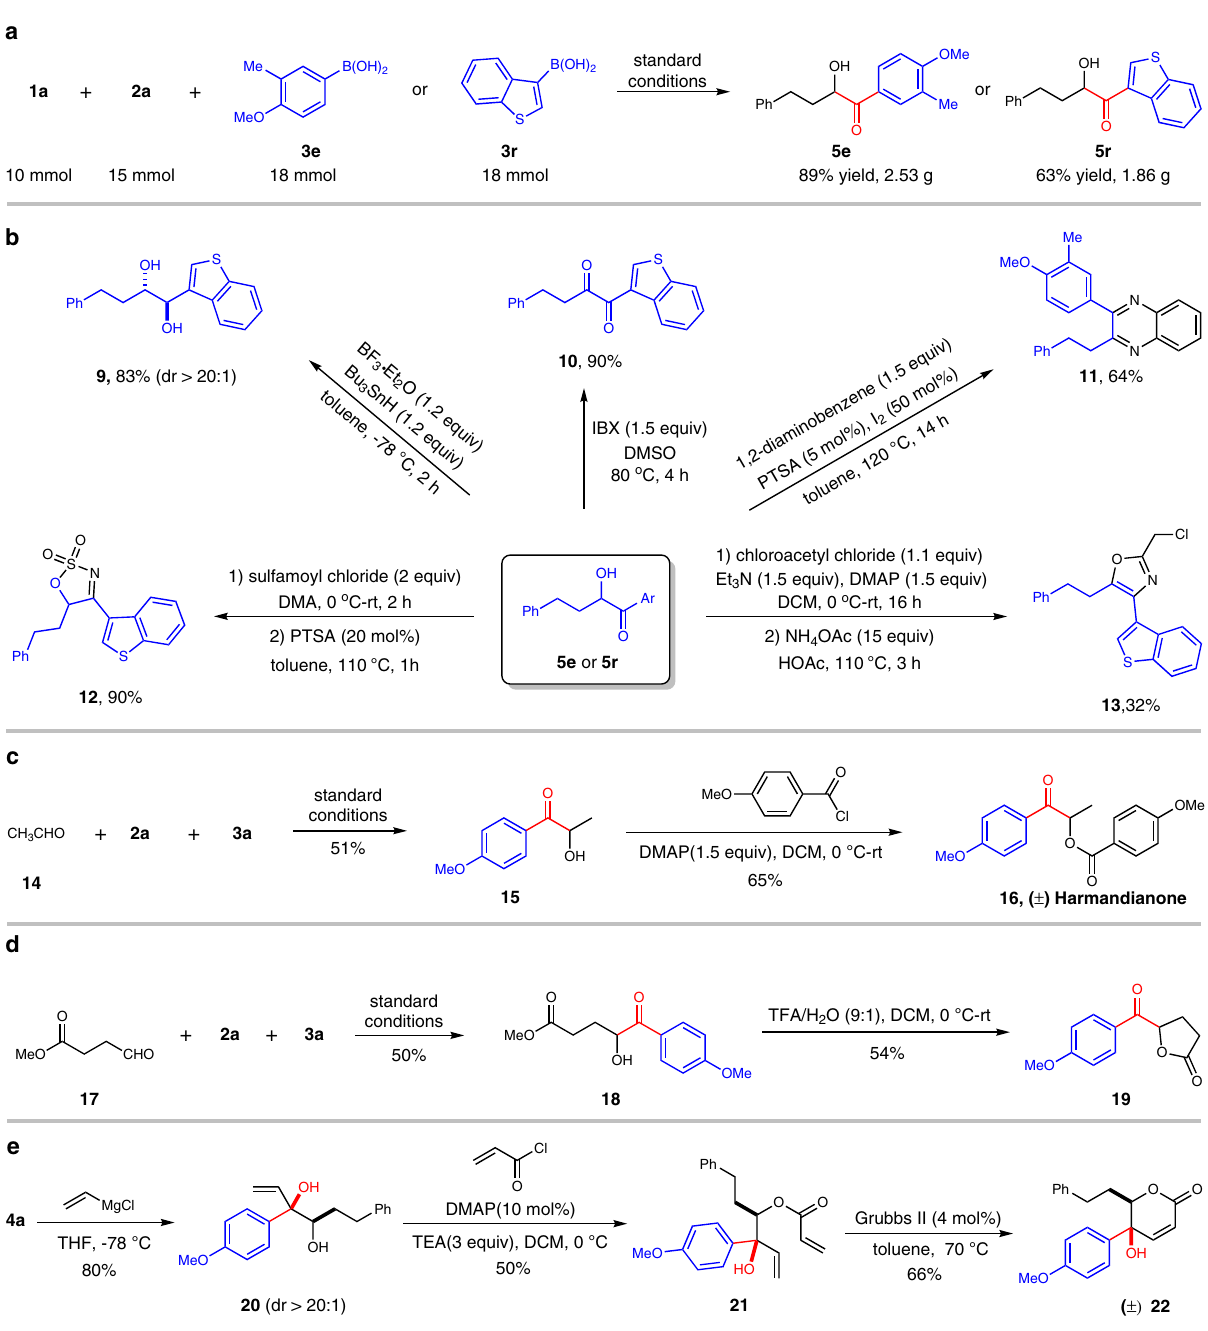
Fig. 6 Gram-scale synthesis and synthetic applications. a Gram-scale synthesis. b Transformations of α -hydroxyketones. c Synthesis of Harmandianone. d Syntheis of α -acyloxy lactone. e Synthesis of α , β -unsaturated